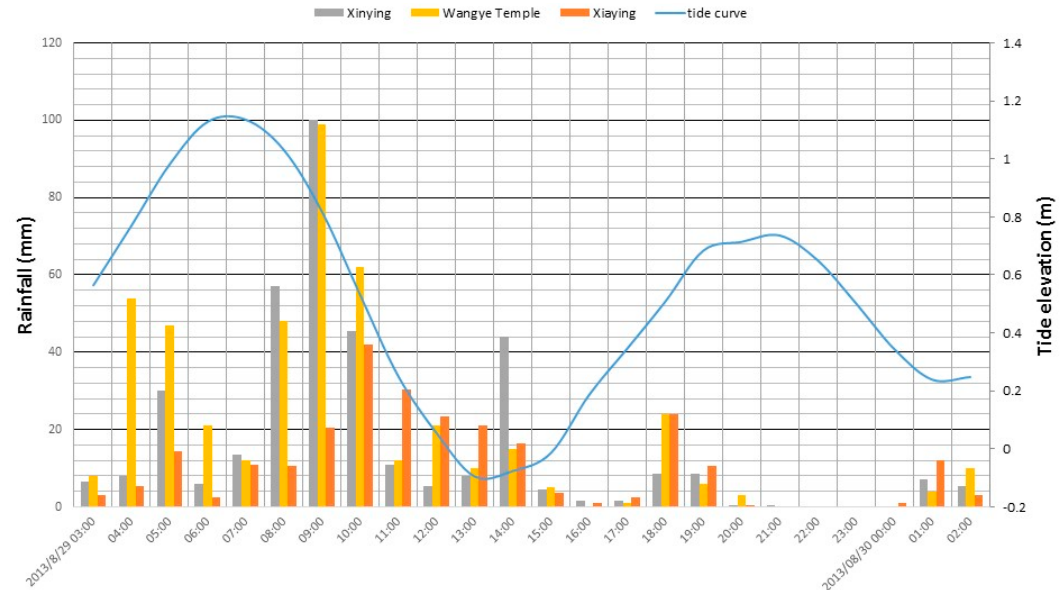
Figure 9. Rainfall histogram at three stations (Xinying, Wangye Temple, and Xiaying) in Jiangjun watershed and the tidal curve downstream during Typhoon Kongrey in August 2013.